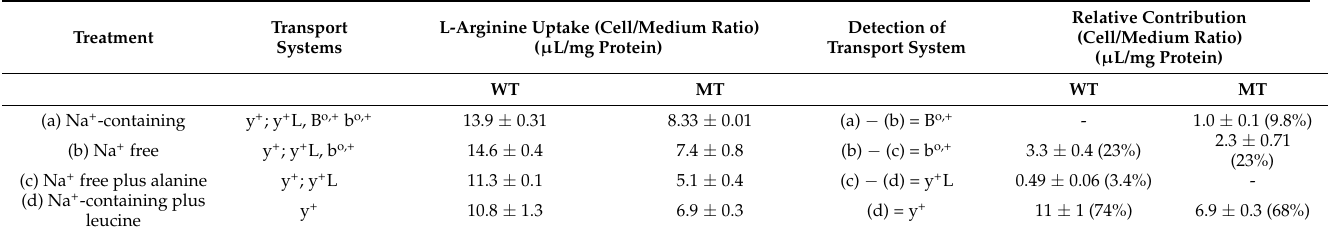
Table 3. Relative contribution of transporters involved in the uptake of [ 3 H]L-arginine in ALS cell lines.